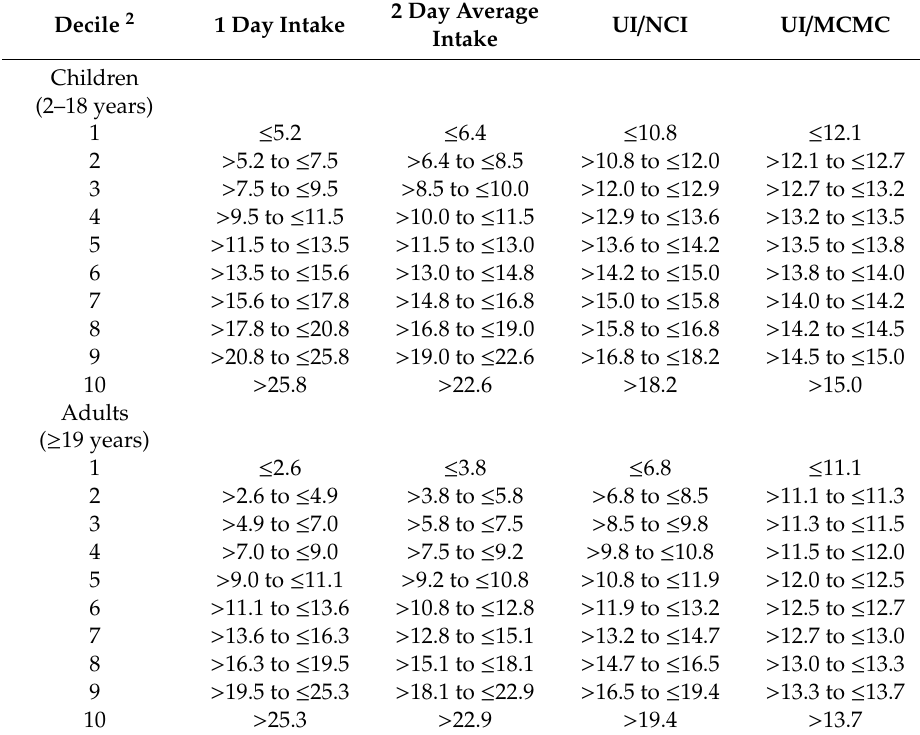
Table 1. Deciles of added sugars intake (% kcal) of the U.S. population by various methods, the